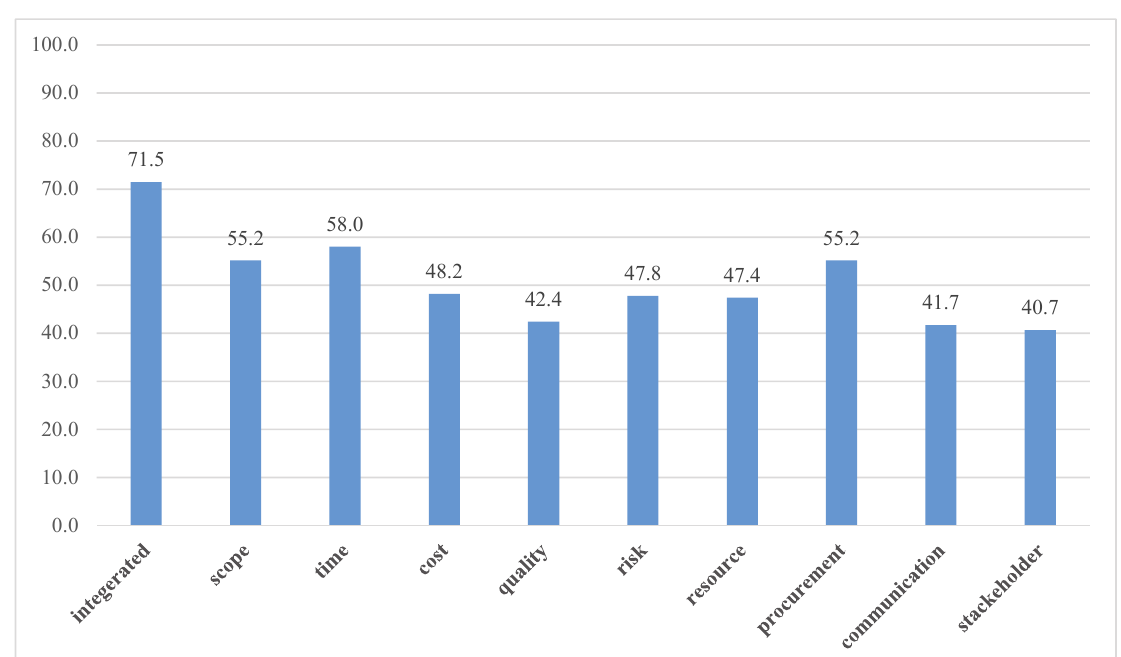
Fig. 2. Graph of the extent of the impact of knowledge areas on BIM